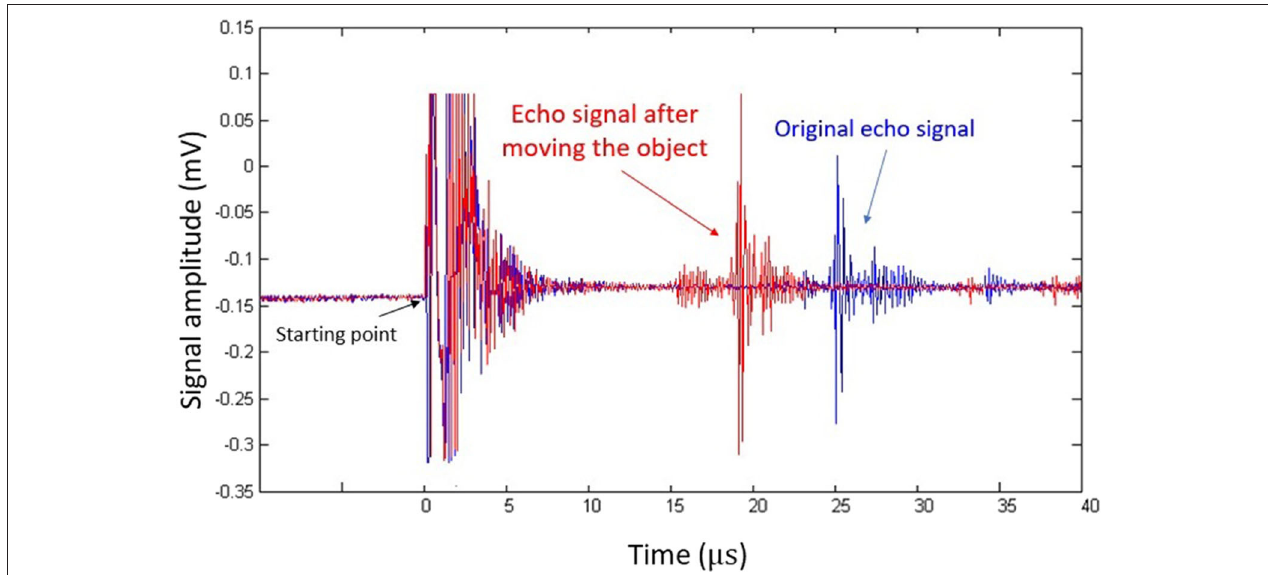
FIGURE 2 | Pulse-echo ultrasound signal acquired in the phantom experiment. The blue plot represents the original echo signal, while the red one represents signals acquired after the flat reflector was placed closer to the transducer.